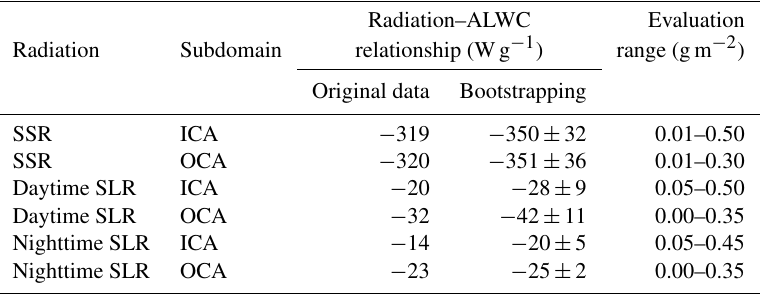
Table F1. Radiation–ALWC relationship (Wg − 1 ) based on the linear fits of Fig. 14g–l including the time period 6 July 15:00UTC to 7 July 15:00UTC. The subdomain denotes whether the captured area is simultaneously cloudy (ICA) or cloud free (OCA) in both realizations. Original data denote the slopes derived from Fig. 14g–l, whereas bootstrapping refers to the median slopes of the 10000 resamples. The confidence intervals are derived by using the Gaussian approximation and α = 0 . 05, and the evaluation range provides the ALWC interval, which is used for the linear